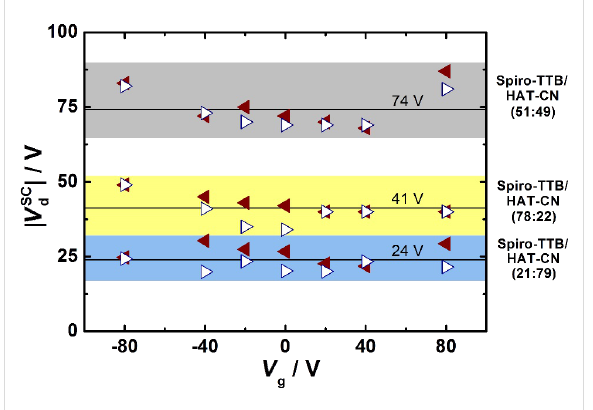
Figure 3: The drain voltage V dSC , at which the sign reversal takes place, is plotted for different V g for all mixing ratios. All points belonging to one mixing ratio are highlighted in a separate colour. Red triangles denote the measurements with positive V d , while white trian- gles represent negative V d . The solid black lines represent the aver- age V dSC values for each mixing ratio.